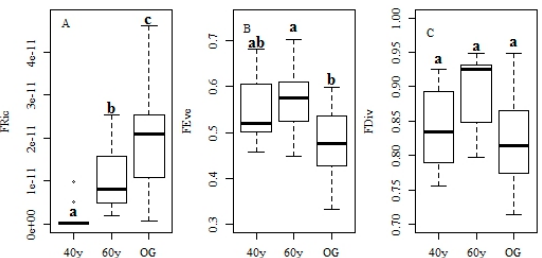
Figure 5. The changes in functional diversity (mean ± SD) with secondary succession of monsoon forests. Subfigures ( A – C ) respectively showed the changes of functional richness (FRic), functional Evenness (FEven), functional divergence (FDiv). Functional diversity was computed based on the tree basal area and all traits were log-transformed. The successional stages were 40-year-old forests (40y), 60-year-old forests (60y) and old-growth forests (OG). Different letters (a, b, c) demonstrated significant different at p < 0.05.